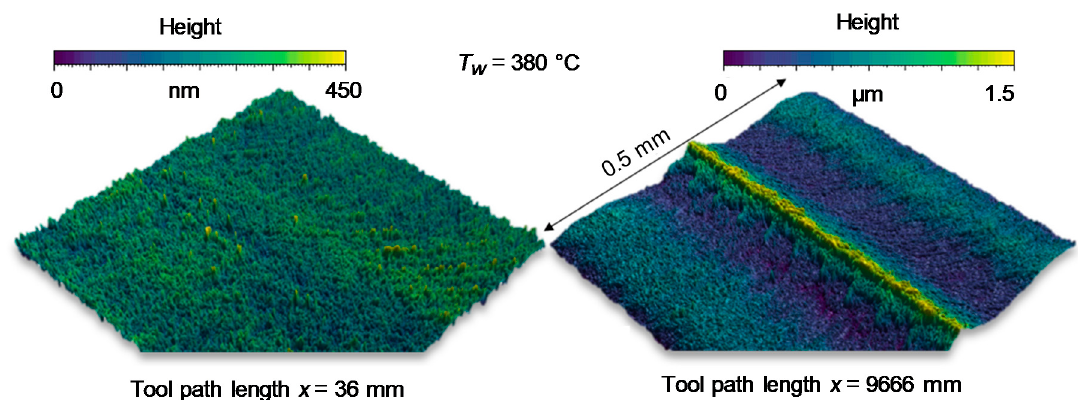
Figure 5. Oxide layers that occur due to the thermally accelerated oxidation of the surface.